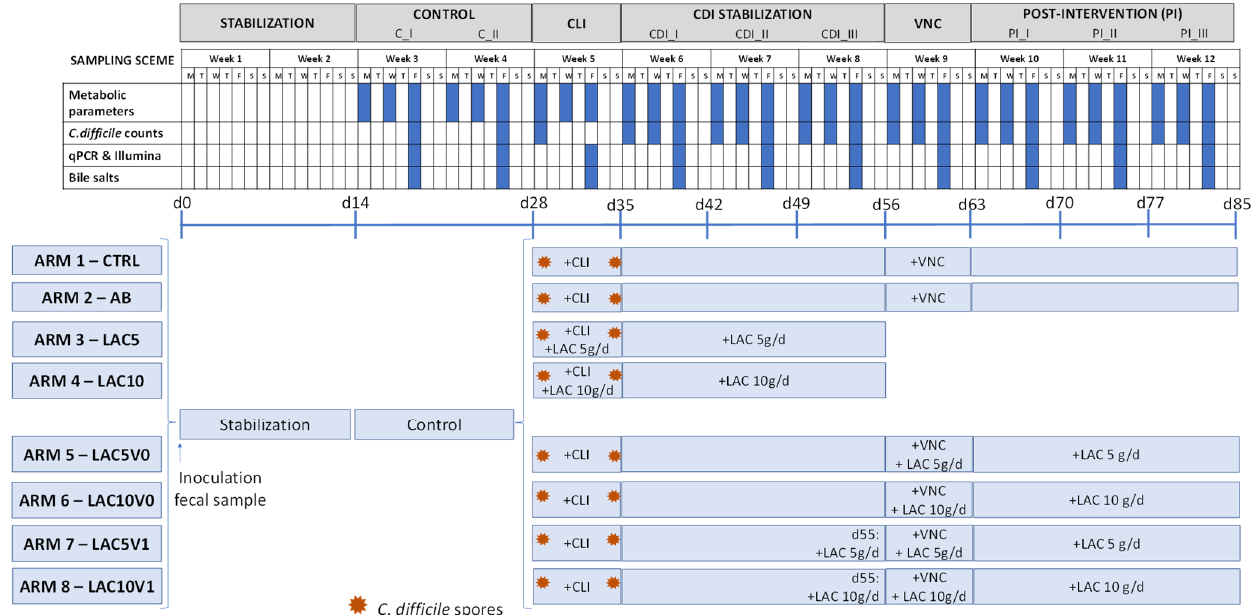
Figure 7. Schematic representation of the experimental set up for each of the eight arms of the PathoGut™ SHIME experiment, including the sampling scheme for each of the experimental periods, i.e., stabilization period (2 weeks), control period (C; 2 weeks), clindamycin treatment period (CLI; 1 week), C. difficile infection (CDI) stabilization period (3 weeks), vancomycin treatment period (VNC; 1 week) and post-intervention period (PI; 3 weeks). Antibiotic and test product additions were indicated for each of the experimental arms by “+”. CLI = clindamycin; FC = flow cytometry; LAC = lactulose; VNC = vancomycin.